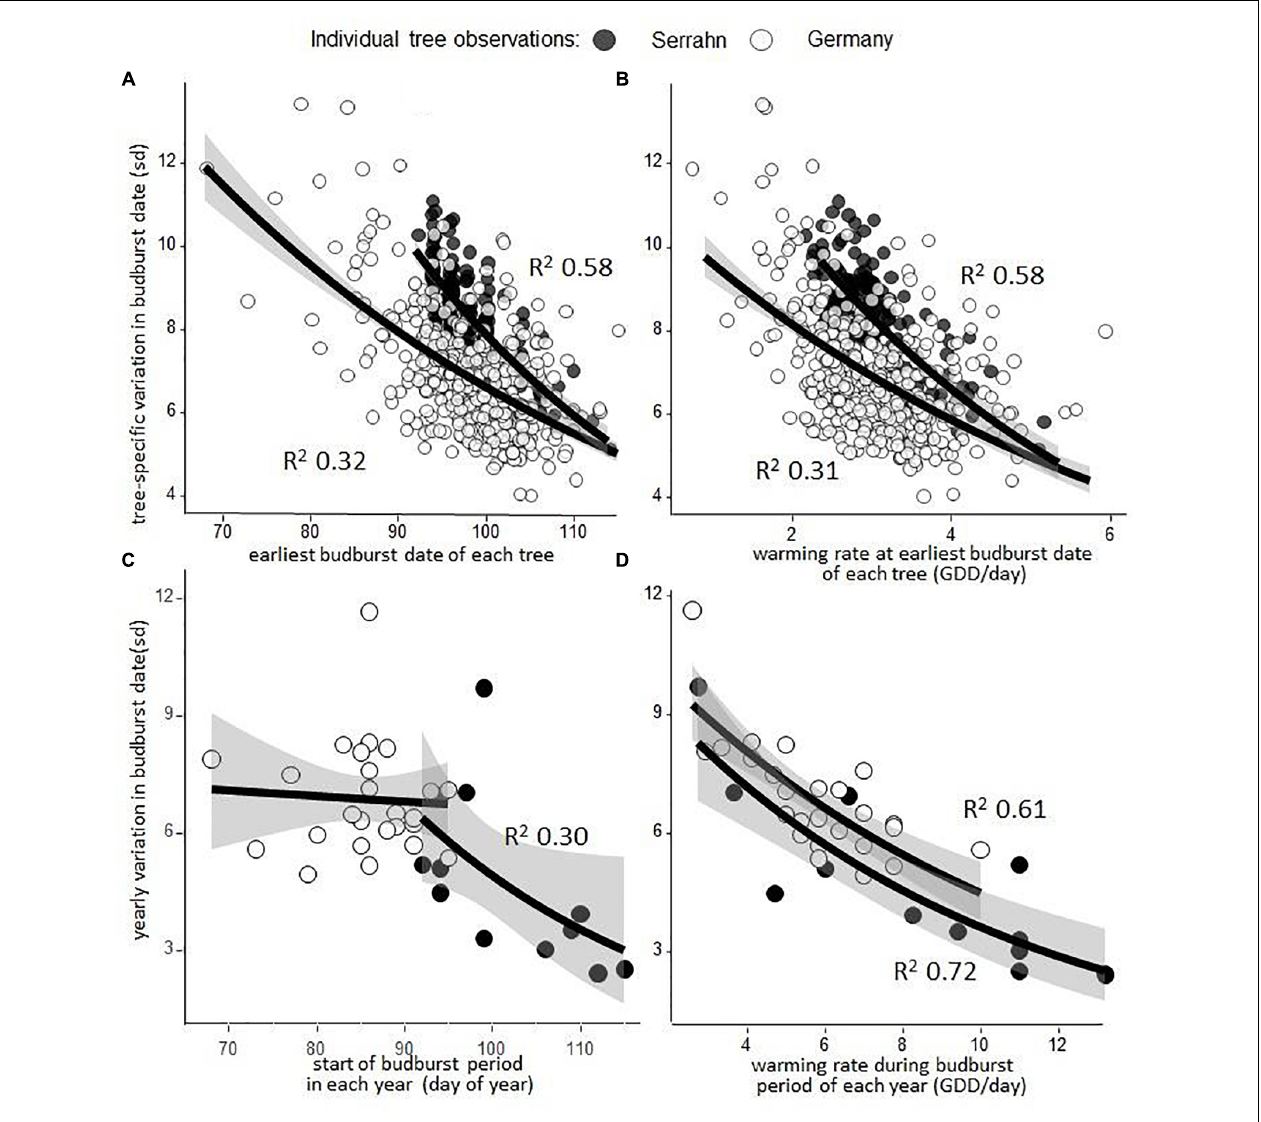
FIGURE 4 | Tree-specific and year-specific variation in budburst dates is determined largely by the rate of warming during the budburst period. (A) The earliest budburst date of each of 146 trees in one forest stand (Serrahn) and of every single tree at 405 sites across Germany, regressed against the variation in budburst dates across the monitored 12 (Serrahn) or 25 (Germany) year periods, respectively. (B) The warming rate at the earliest budburst date for each monitored tree, quantified as mean GDD accumulation per day across the monitored years, regressed against the variation in budburst dates across the monitored 12 (Serrahn) or 25 (Germany) year periods, respectively. (C) The start of the budburst period in a forest stand (Serrahn) and across Germany in each year, regressed against the respective yearly variation in budburst date. (D) Warming sum accumulation rate in each year (GDD/day) in a forest stand (Serrahn) and across Germany during the budburst period, regressed against the respective yearly variation in budburst date. See section “Materials and Methods” for the budburst period definition.